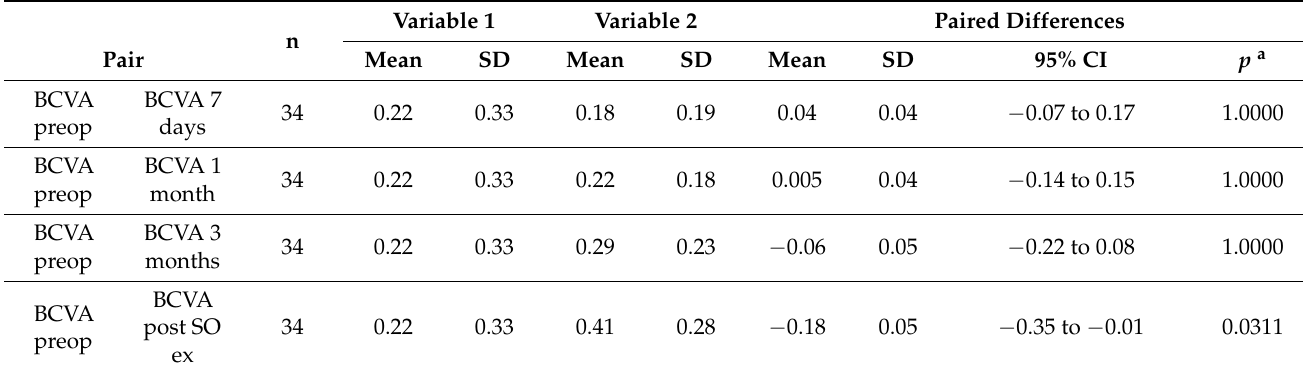
Table 1. Best-corrected visual acuity (BCVA) in operated eyes